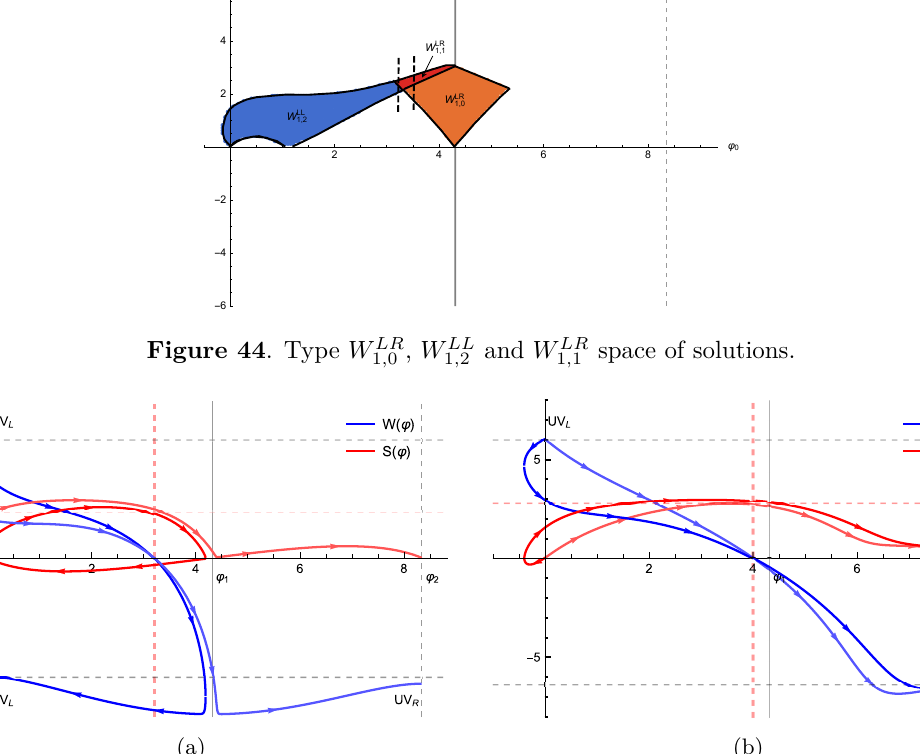
) and type W LL R